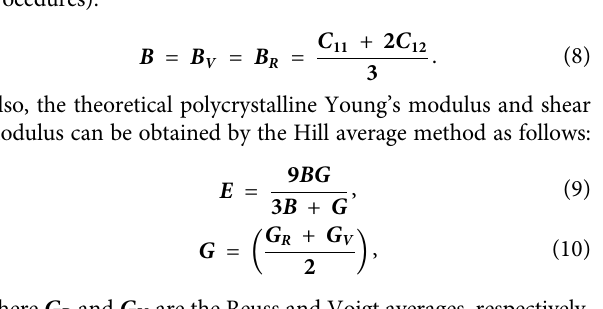
methods (Hill arithmetic average, Voigt, and Reuss averaging